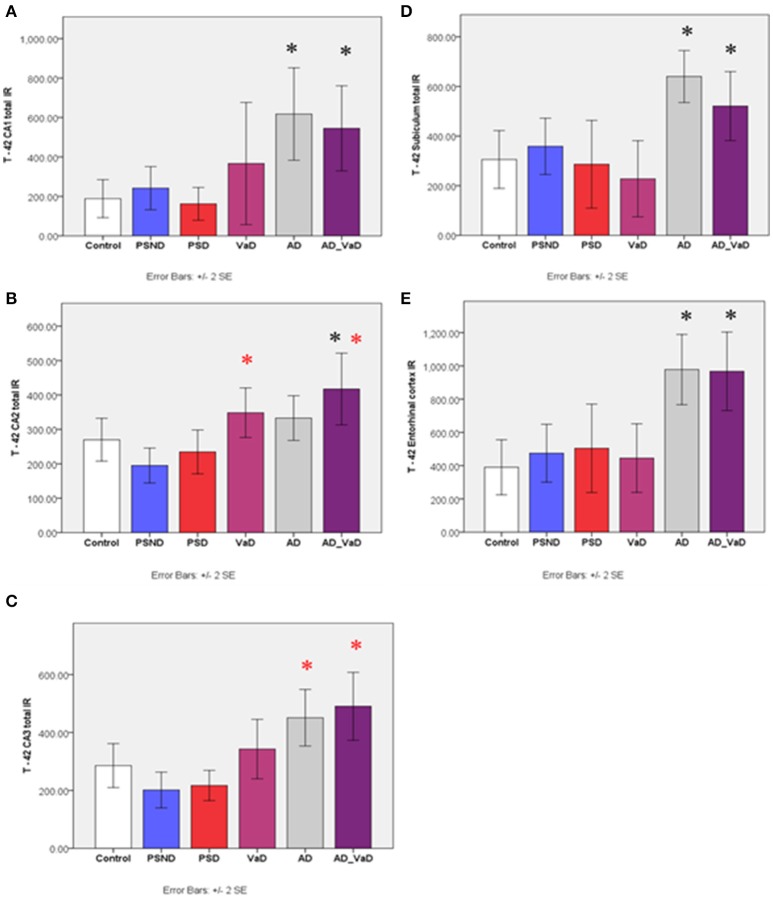
Bar graphs showing the distribution of Aβ-42 IR across hippocampal sub-regions (A) CA1, (B) CA2, (C) CA34, (D) Subiculum, (E) Entorhinal cortex in Controls, PSND, PSD, AD, VaD, and AD_VaD. Bars show ± 2 SEM *Mann Whitney U-test was used to compare means of each group. *p < 0.05; + p < 0.1 (in comparison with control group). *(red) showed significant difference from PSND group. IR (immunoreactivity).